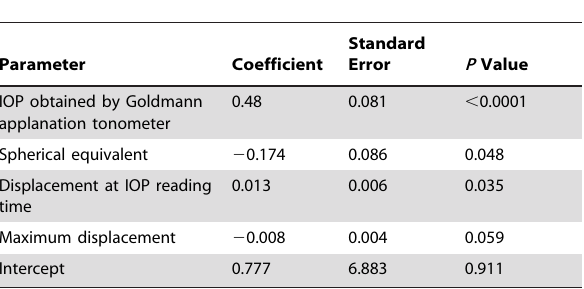
Table 4. Results of the multiple linear regression analysis with the stepwise method in which the IOP obtained by non- contact tonometry was the outcome variable.